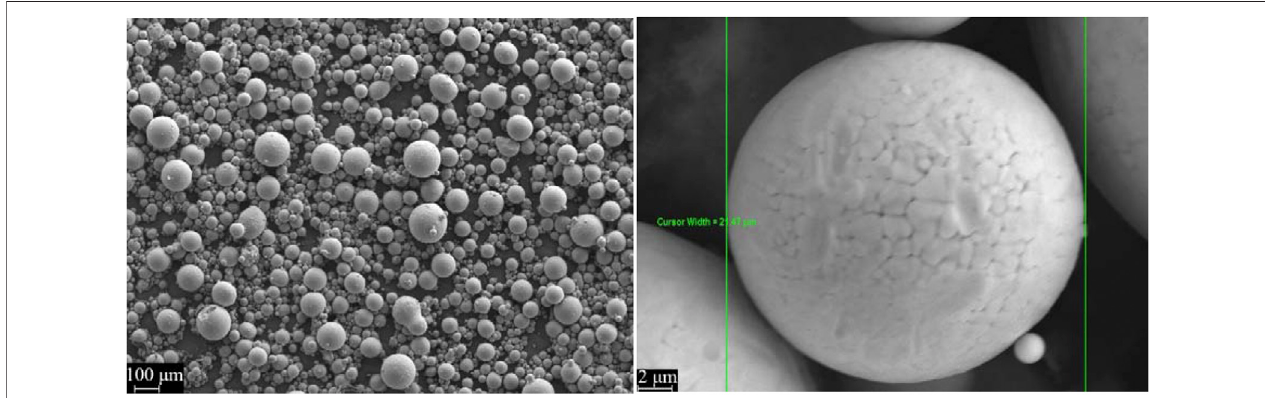
TABLE 1 | Chemical composition and physical properties of 304 stainless steel powder prepared from different atomization processes. Process procedure AISI304